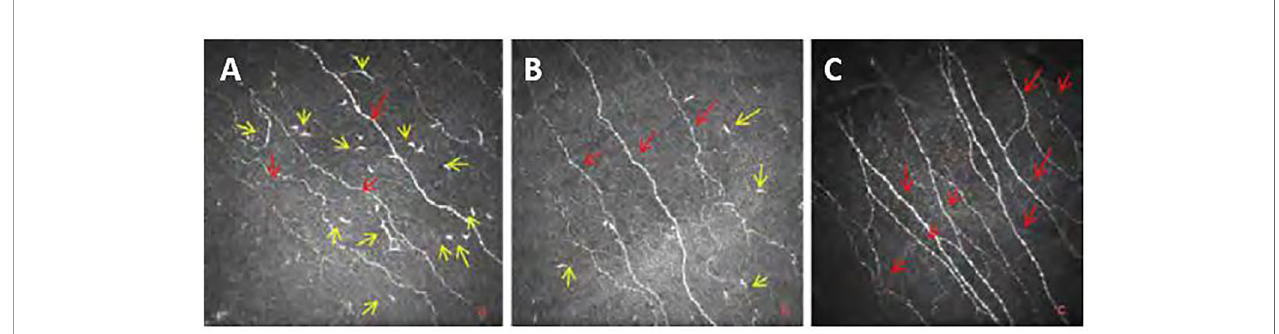
FIGURE 2 | Images from Bowman ’ s layer of the cornea at (A) T2DM with mild neuropathy; (B) moderate neuropathy; (C) Healthy Control Subject (yellow arrows show LCs and red arrows indicates main corneal nerve c nerve fi